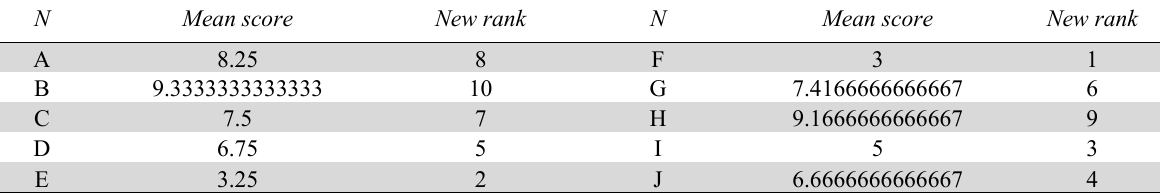
Reflection of the conducted expert evaluation of the block Experts/Factors